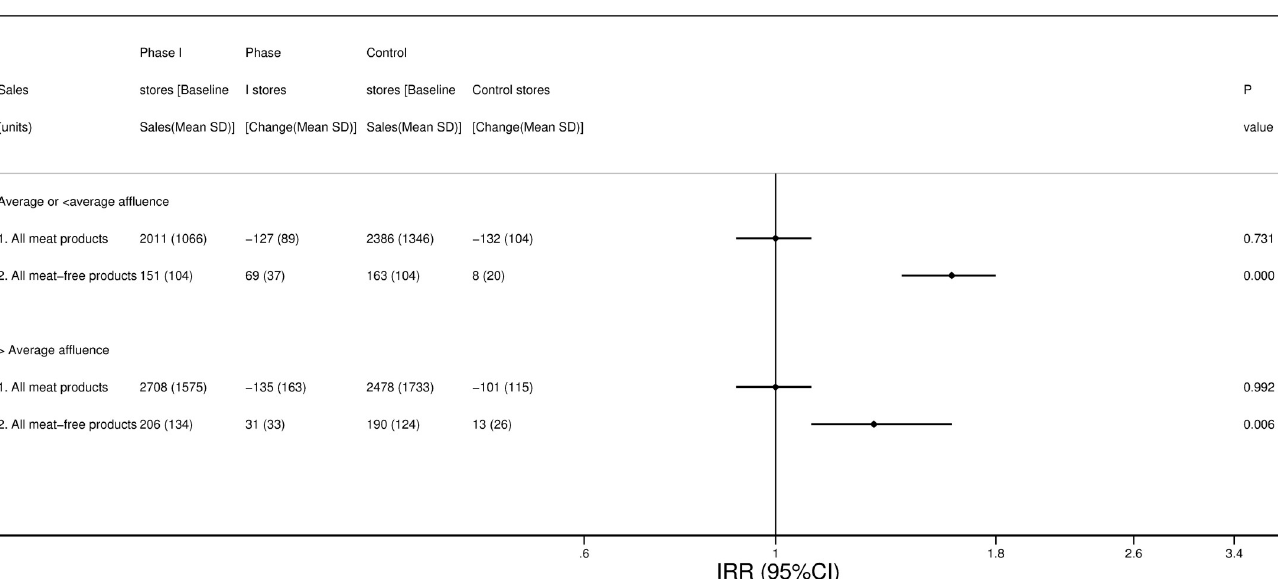
Fig 4. Average baseline sales (units/ items sold) per store per week and comparison of changes between intervention and control stores over the Phase I intervention period by store affluence. � Changes in intervention vs. control stores were compared using hierarchical negative binomial models with fixed effect adjustment for store affluence, store age group, store ethnicity, store area and average units sold per week in 12-week pre-intervention period (week commencing September 2, 2018 to week commencing November 18, 2018) and a random effects term for matching group. To compare the effect of the intervention across affluence groups, interaction terms (affluence groups � intervention) were included in the model: P interaction for meat products = 0 � 738; P interaction for meat-free products = 0.021.